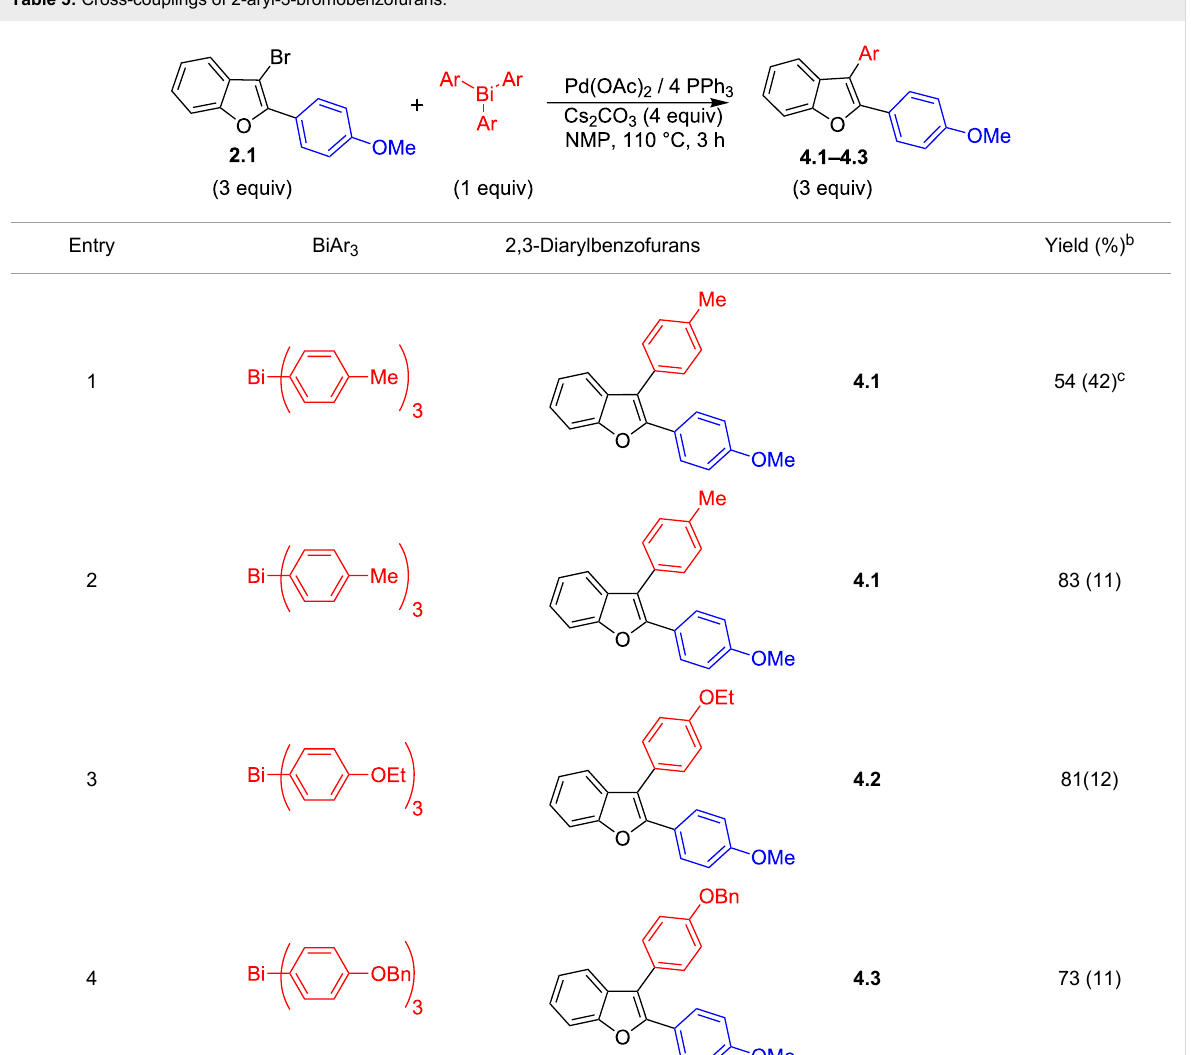
Table 5: Cross-couplings of 2-aryl-3-bromobenzofurans.